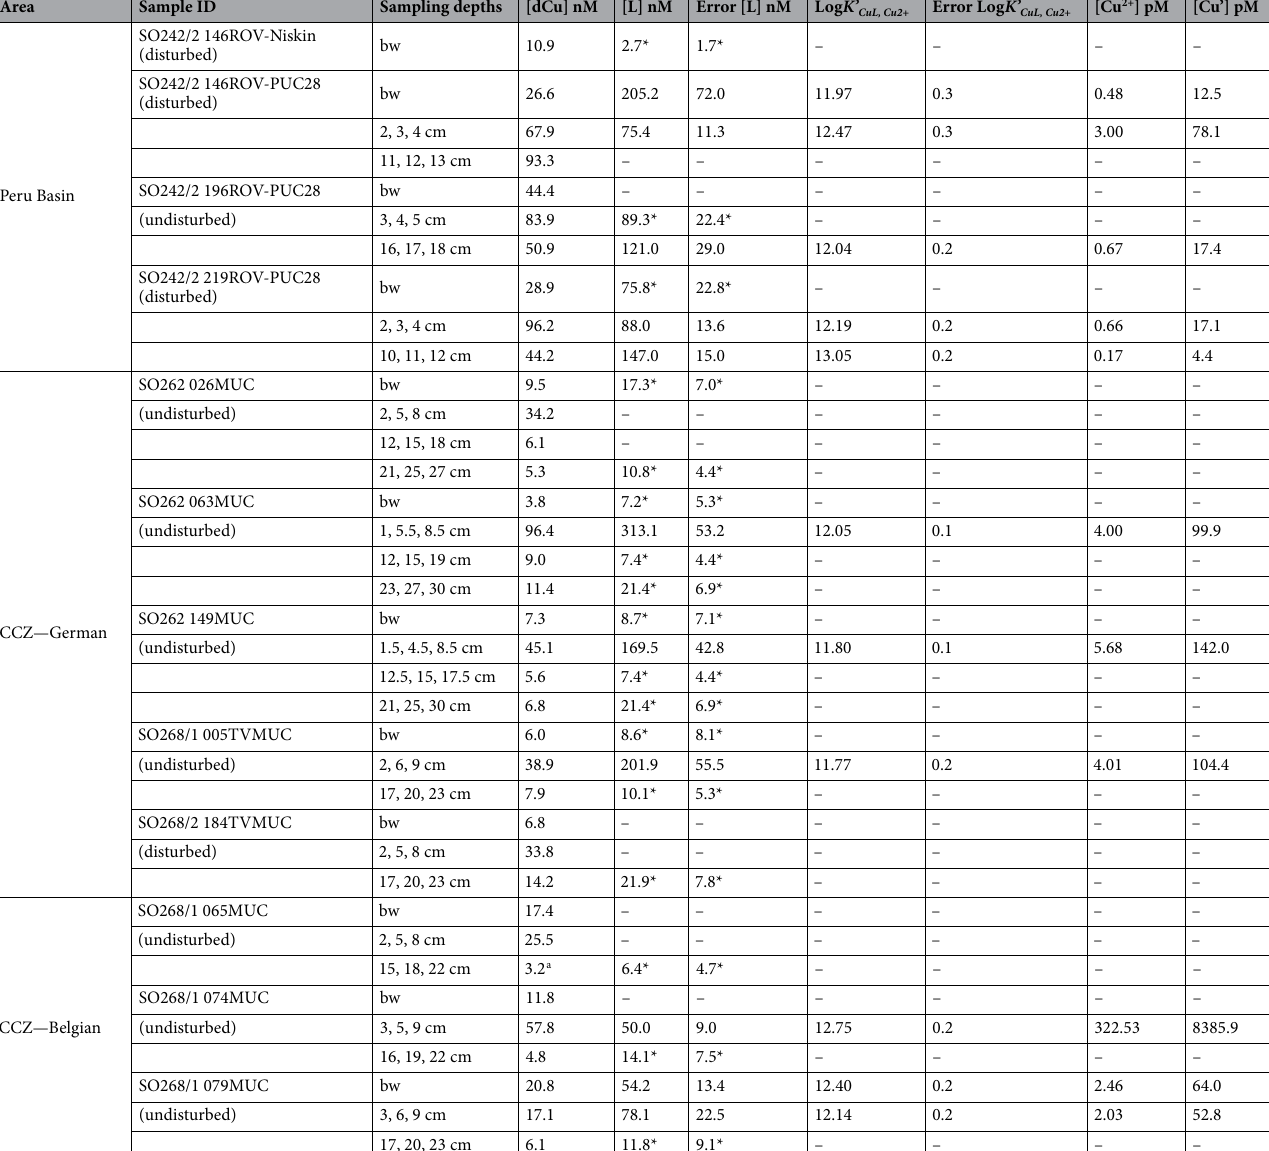
Table 2. Overview of [dCu], [L], Log K’ CuL, Cu2 + , [Cu 2+ ], and [Cu’] for all samples. [L T ] (L T = total L, sum of L 1 and